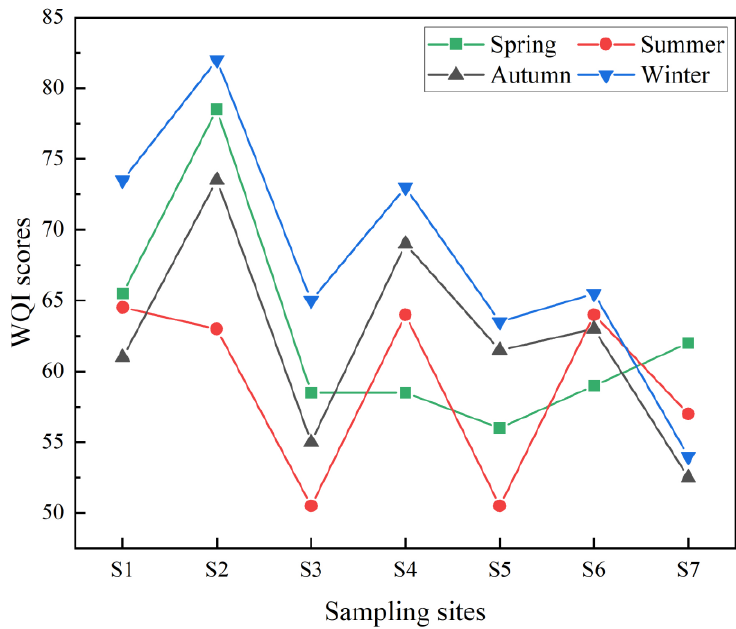
Figure 2. Comparison of WQI between sampling sites in different seasons.